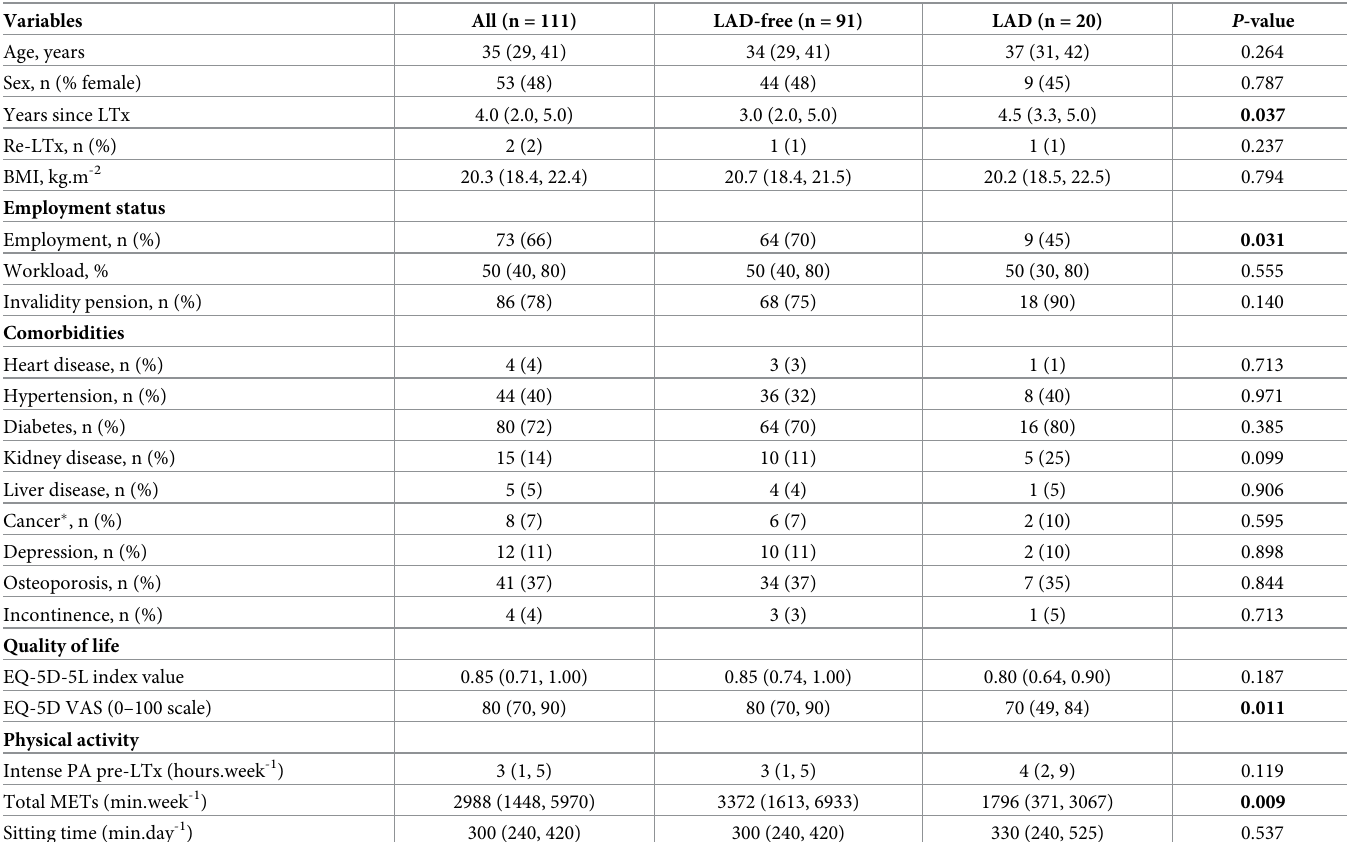
Table 1. Participants’